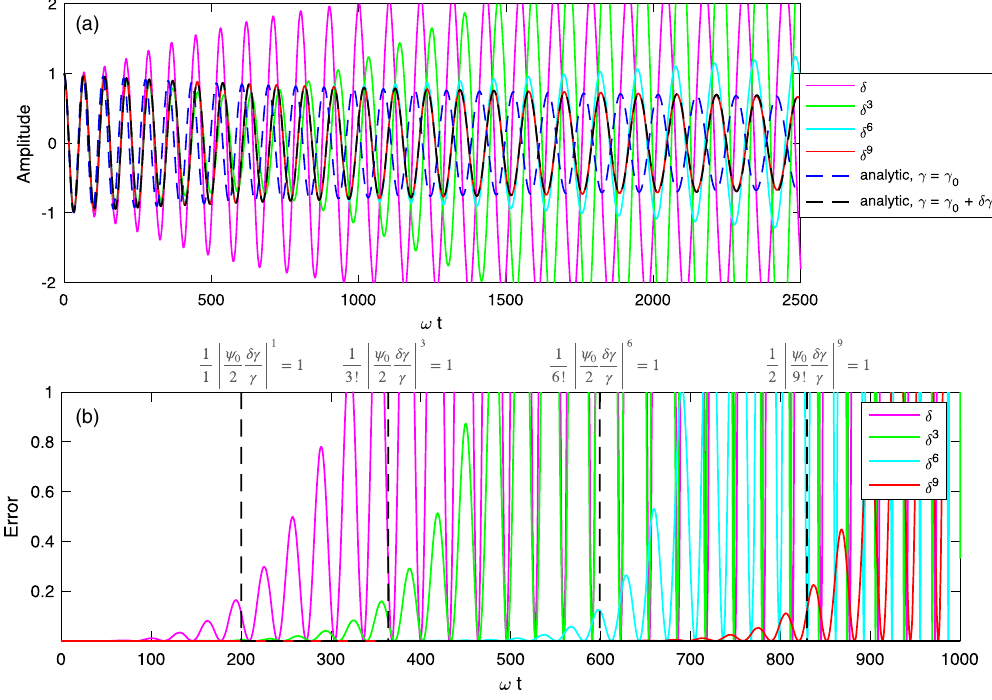
FIG. 9. Betatron oscillations modeled using the expanded nonlinear transfer matrix in Eq. (B4). (a) Oscillations with an increasing γ factor from γ 0 ¼ 100 to γ 0 ¼ 500 corresponding to linear acceleration. The dashed lines correspond to analytic (WKB) solutions for betatron oscillations for the design γ ¼ γ 0 (blue) and γ ¼ γ 0 þ δγ (black), for a energy deviation δγ ¼ 10 . The colored solid lines indicate solutions using the nonlinear matrix with different orders in δ ¼ δγ = γ up to the δ 9 th term, i.e., m ¼ 9 . (b) The error in the solution for oscillations with fixed γ ¼ 100 , defined as j x including terms up to m . The black dashed lines show the thresholds j ψ 0